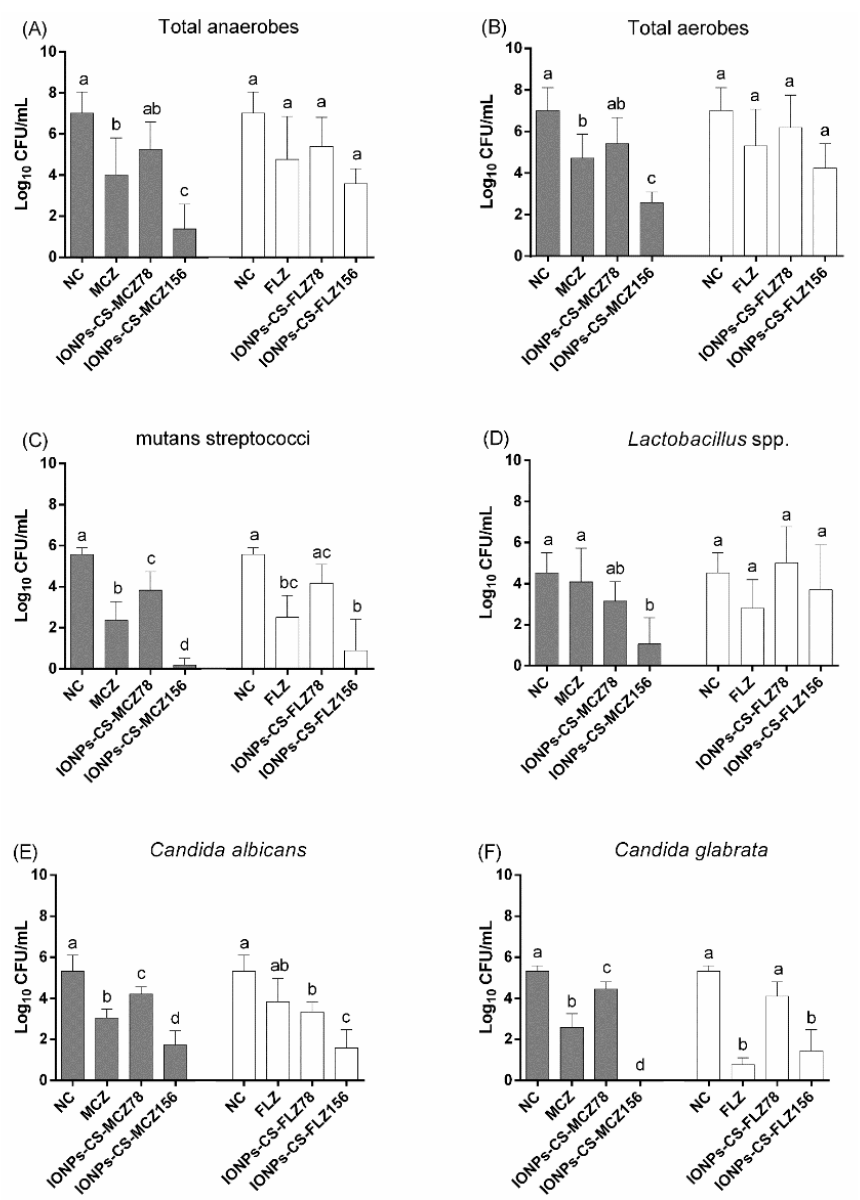
colony-forming units (CFUs) compared to the negative control (NC) (Figure 1A,B). IONPs- CS-MCZ156 was the most effective treatment, which was significantly better than free MCZ, leading to reductions of 5.65- ( p = 0.046) and 4.43-log 10 ( p = 0.037) for total anaerobes and aerobes compared to the NC, respectively.